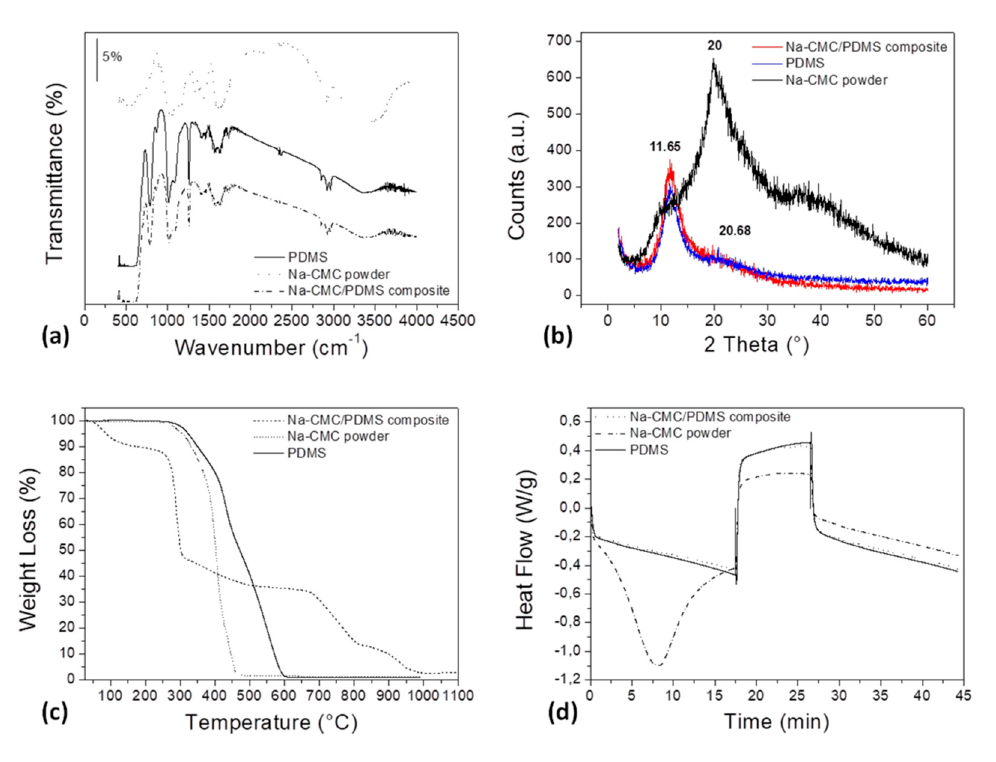
Figure 1. Comparison of the properties of neat polydimethylsiloxane (PDMS), sodium carboxymethylcellulose (Na–CMC) powder, and the Na-CMC/PDMS composite, in terms of: ( a ) Fourier Transform Infrared Spectroscopy (FTIR) spectra; ( b ) X-ray Diffraction (XRD) patterns; ( c ) thermogravimetric analysis (TGA) and ( d ) Differential Scanning Calorimetry (DSC) thermograms.